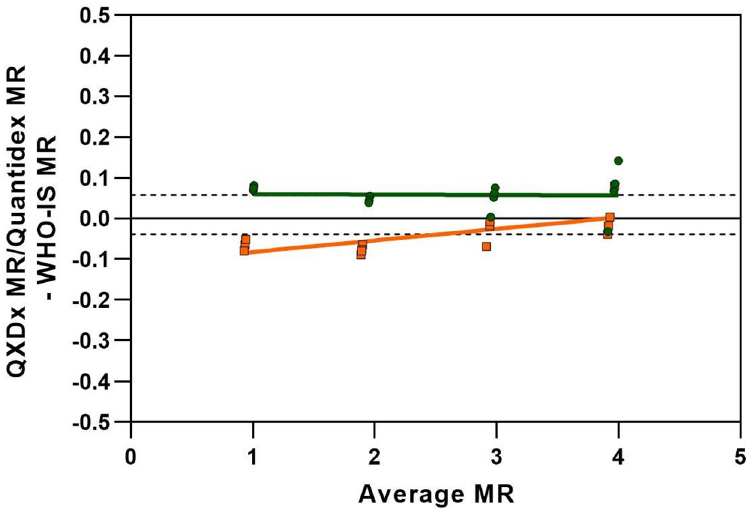
Fig 7. WHO-IS method comparison. Correlation between ddPCR and qPCR on WHO-IS Samples. The ddPCR linear fit is the solid green line and the qPCR linear fit is the solid orange line, the mean bias for each method is shown in the dotted black line which were 0.058 for ddPCR and -0.039 for qPCR.